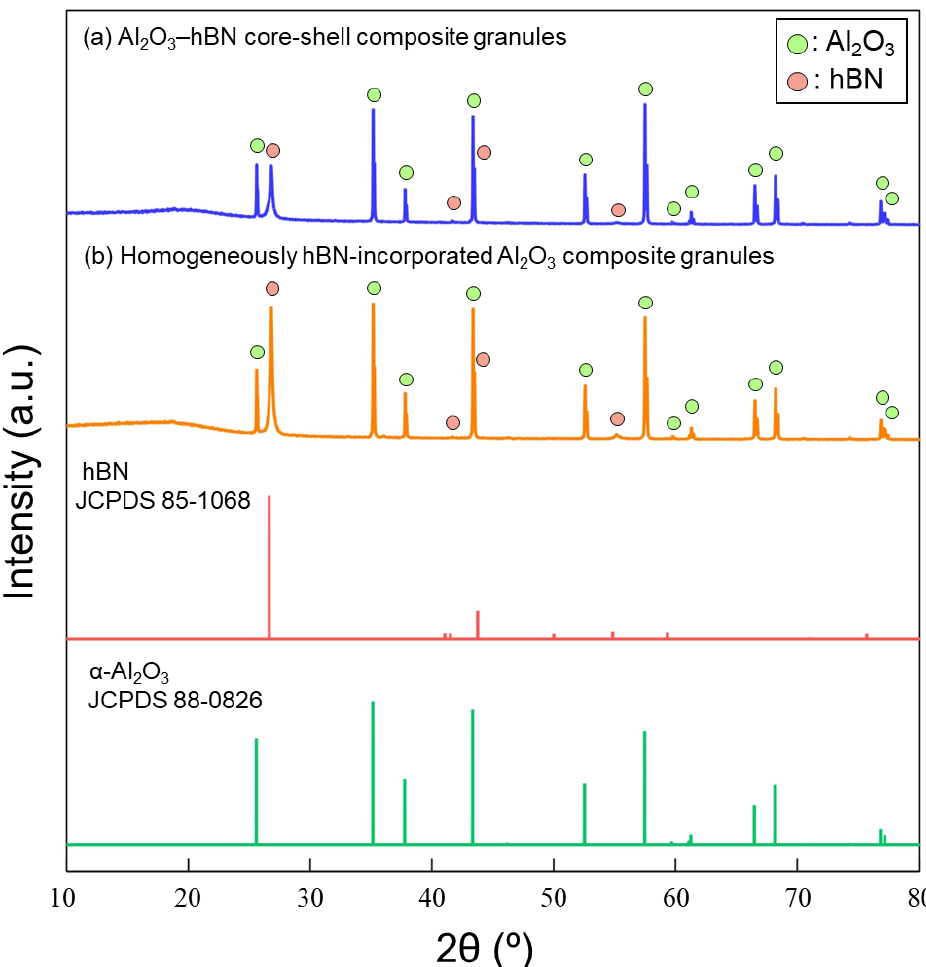
Figure 8. XRD patterns of the sintered composite artifacts obtained using ( a ) Al 2 O 3 –hBN core–shell composite granules and ( b ) homogeneously hBN-incorporated Al 2 O 3 composite granules.